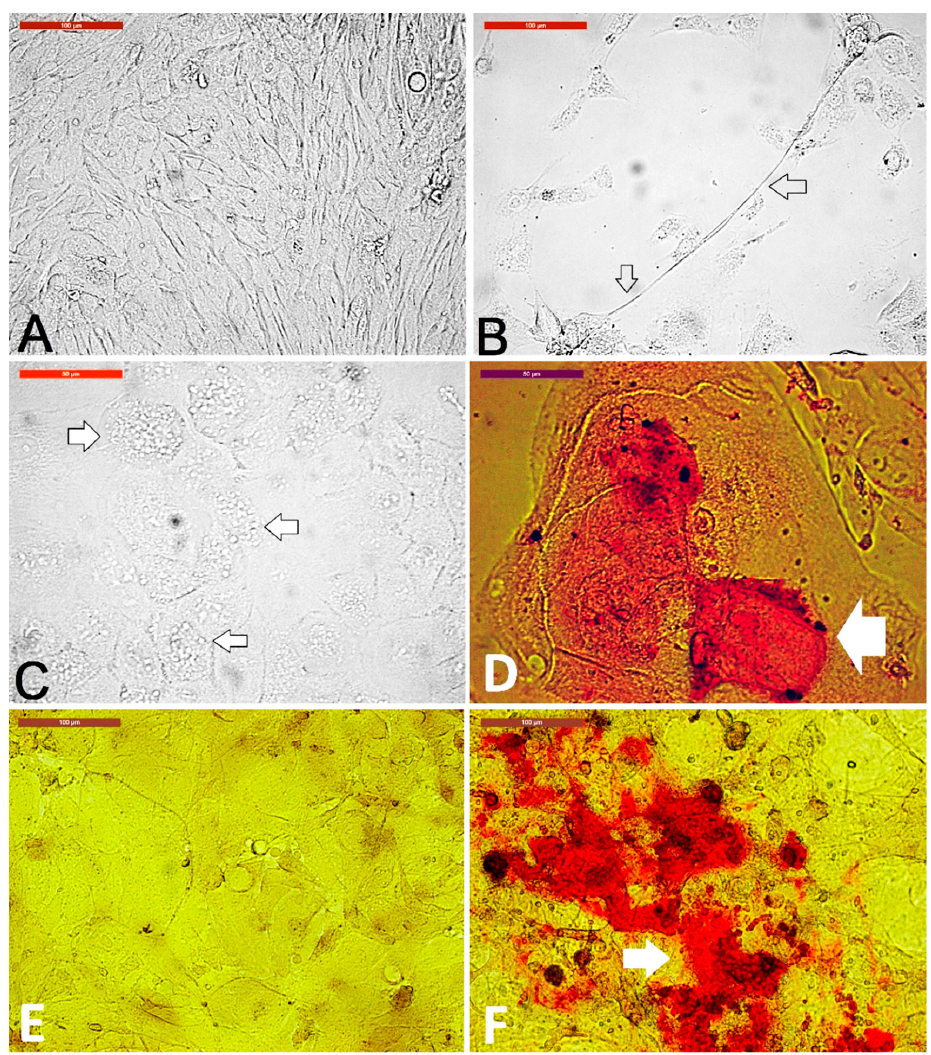
Figure 8. Dermal spheroid differentiation. Individual dermal spheroids were collected and cultured in plain medium ( A ) showed formation of spindle-shaped cells. Scale bar = 100 µm. Spheroids were cultured in a medium containing 10 µg/mL of all-trans retinoic acid for neurogenic differentiation ( B ) with axon-like formation (arrows). Scale bar = 100 µm. Spheroids cultured in medium containing adipogenic-differentiation factors showed formation of lipid droplets uniformly distributed in polygonal cells after 10 days of culture ( C ) and were positive for oil-red stain after 18 days of culture (( D ), red stain, arrow). Spheroids cultured in medium without differentiation factors ( E ) compared to spheroids cultured in a medium containing osteogenic-differentiation factors showed positively stained mineralization after Alizarin red staining (( F ), red stain, arrow). Scale bar = 100 µm.